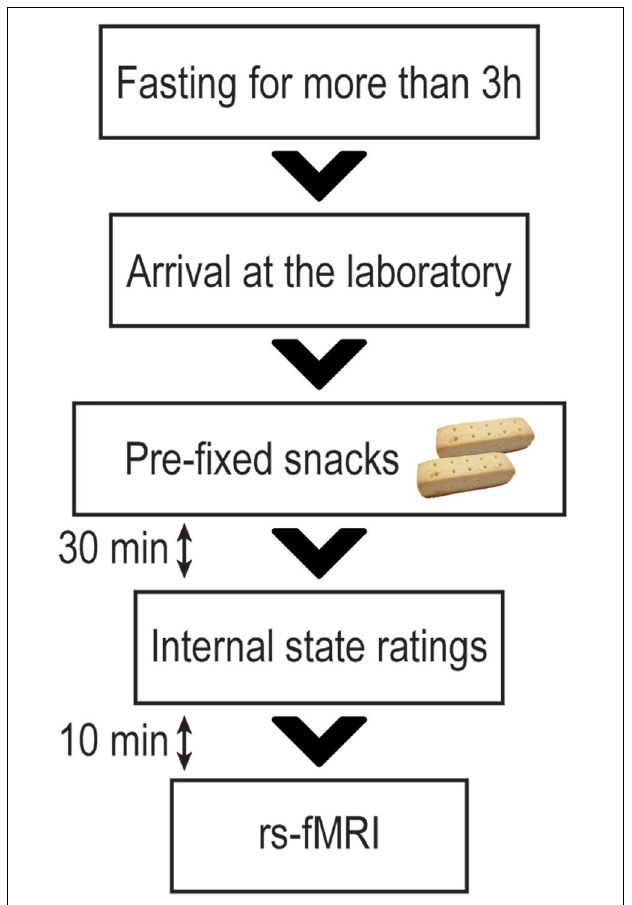
FIGURE 1 | Resting-state functional magnetic resonance imaging session. All participants were instructed to abstain from any food or drinks apart from water for at least 3 h before their visit to the laboratory. Approximately 30 min before the resting-state functional magnetic resonance imaging (rs-fMRI) scanning, each participant was instructed to consume pre-prepared snacks (280 kcal) to standardize their internal states of hunger and fullness. Approximately 10 min before the rs-fMRI scanning, participants rated their levels of hunger and